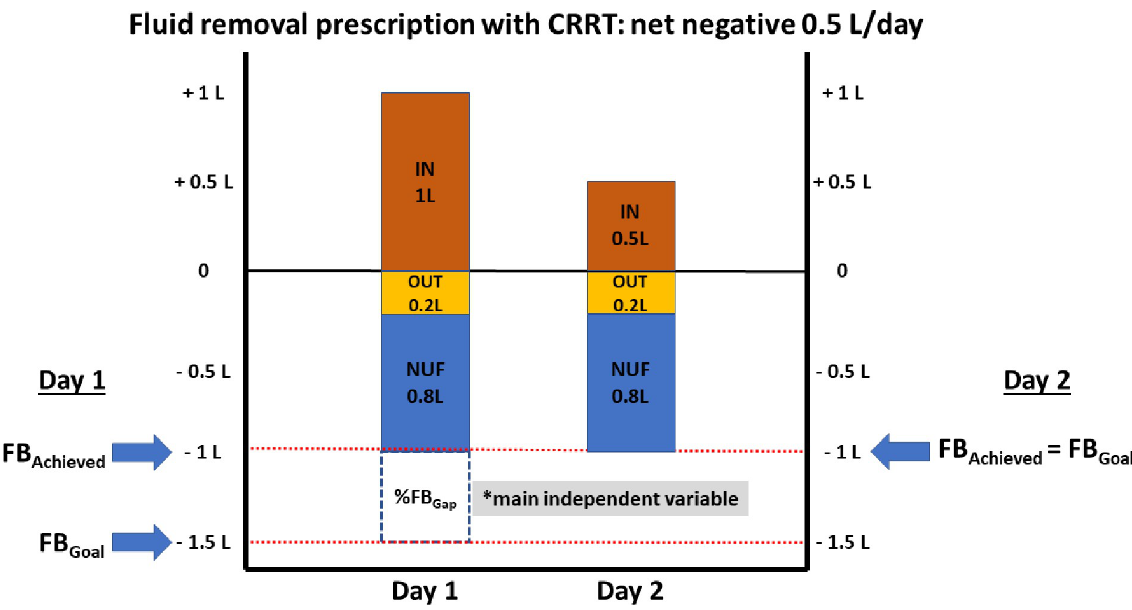
Fig 1. Conceptual map of fluid management parameters used during CRRT. In this patient example, the fluid removal prescription with CRRT is net negative 0.5 L per day for both represented days. One should note that despite similar NUF is attained in both days, fluid balance status is different in both days. On CRRT Day 1, FB Achieved is 0 and therefore %FB Gap is 100%. In contrast, on CRRT Day 2, FB Achieved is -0.5 L and therefore %FB Gap is 0%. Abbreviations: NUF (net ultrafiltration rate); FB Goal (patient fluid balance goal); FB Achieved (patient fluid balance achieved); %FB Gap (Gap of patient fluid balance achieved vs.